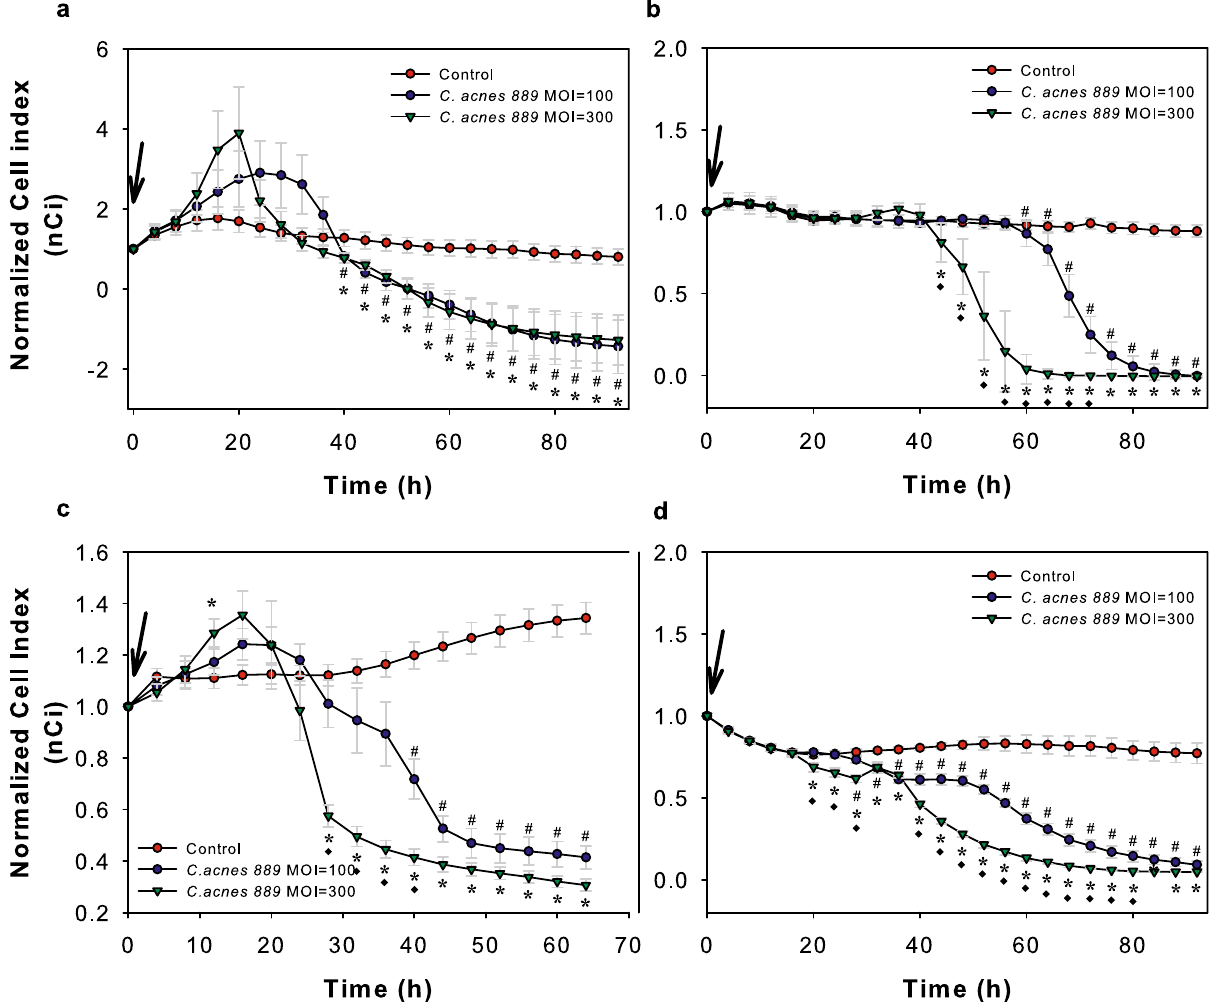
Figure 2. Co-culturing HPV-KER and NHEK keratinocyte monolayers with C. acnes 889 strain leads to dose-dependent nCi changes. Ca-low and Ca-high NHEK ( a , b , respectively) and HPV-KER ( c , d , respectively) keratinocyte monolayers were established and co-cultured with C. acnes 889 strain (0 h time point, marked with an arrow) in different doses (MOI = 100, 300). Addition of the bacterium induced dose-dependent nCi changes in all cultures. (For detailed description, see the corresponding text.) Data points are measured in every 4 h, representing the mean ± SEM. Statistical analysis with one-way ANOVA, post-hoc Tukey test, p < 0.05, alpha = 0.05, # control vs. C. acnes 889, MOI = 100, *control vs. C. acnes 889 , MOI = 300, ♦ C. acnes 889 , MOI = 100 vs. C. acnes 889, MOI =